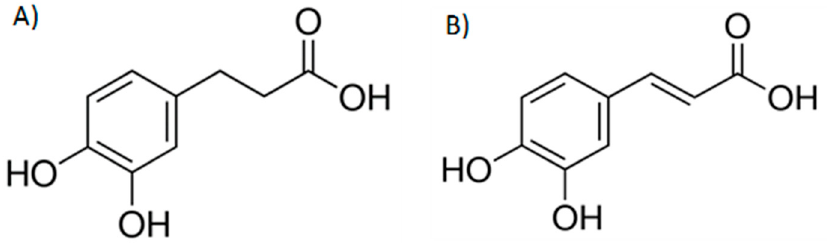
Figure 1. Chemical structures of dihydrocaffeic acid, DHCA ( A ) and caffeic acid, CA ( B